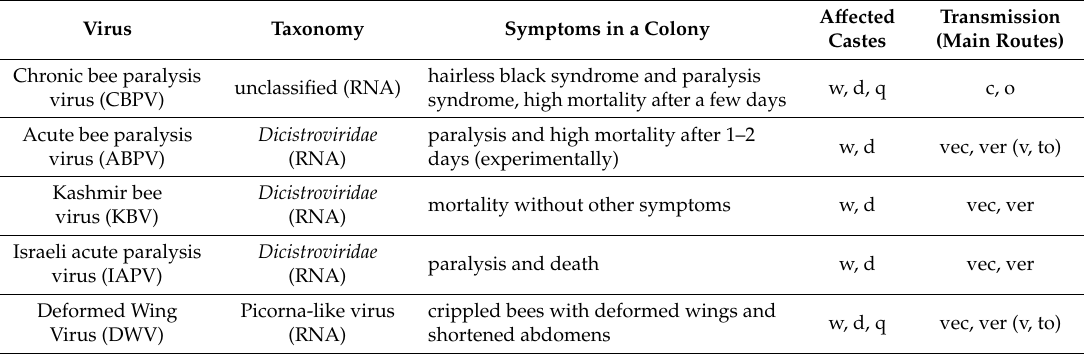
A ff ected Transmission Castes (Main Routes) w, d, q c, o w, d vec, ver (v, to) w, d, q vec, ver (v,